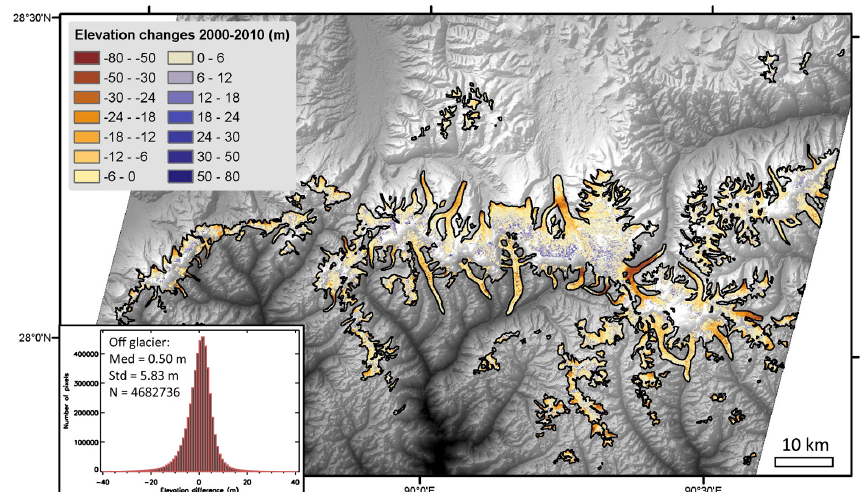
Fig. 3. Same as Fig. 2 but for the Bhutan study